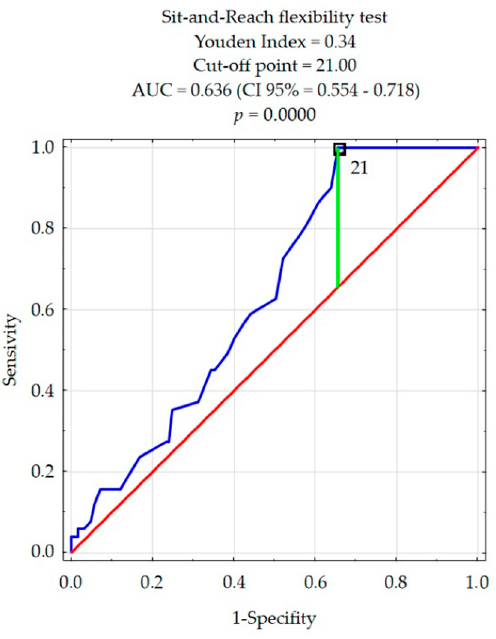
Figure 2. The cut-off point for the level of flexibility by frequency of injuries.